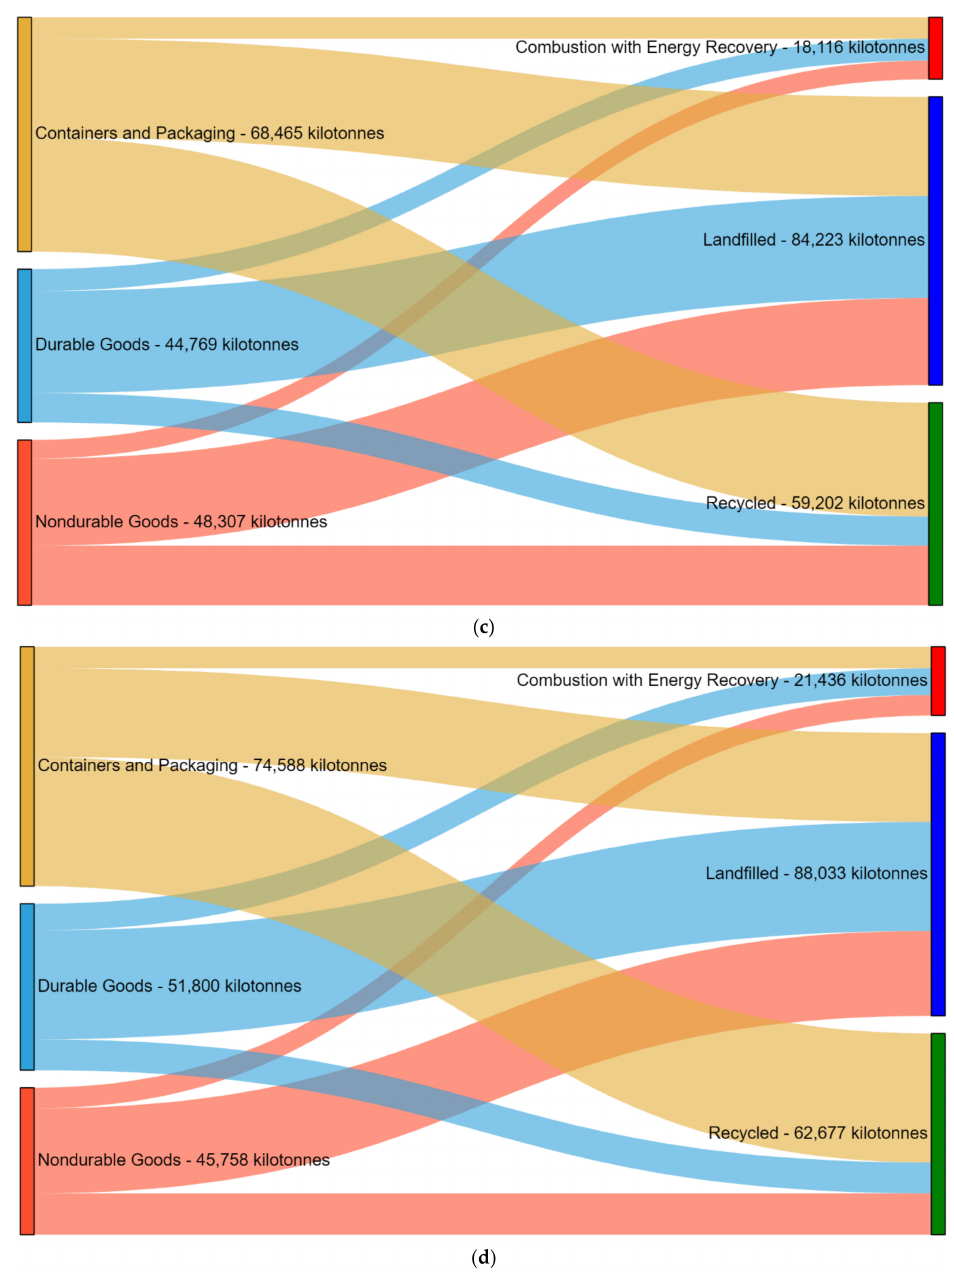
Figure 1. Products in the municipal waste stream, types, and disposition, in thousands of tonnes, years: ( a ) 1990, ( b ) 2000, ( c ) 2010, and ( d )